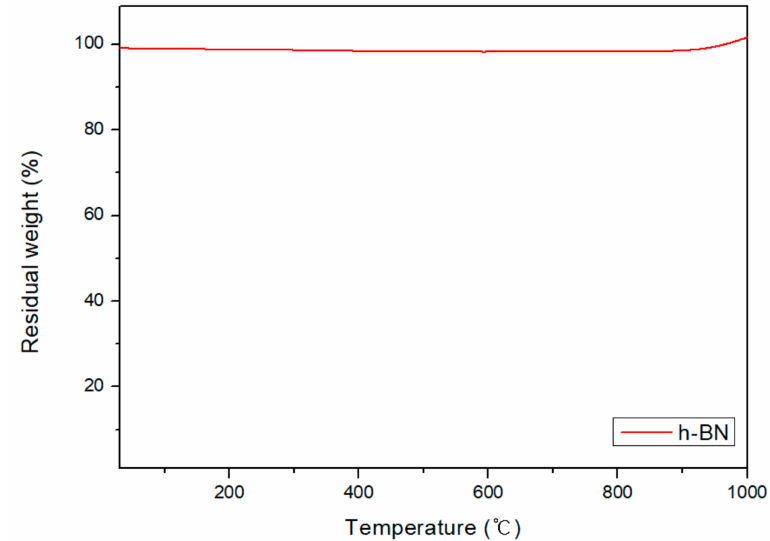
Figure 11. TGA thermograms of pure